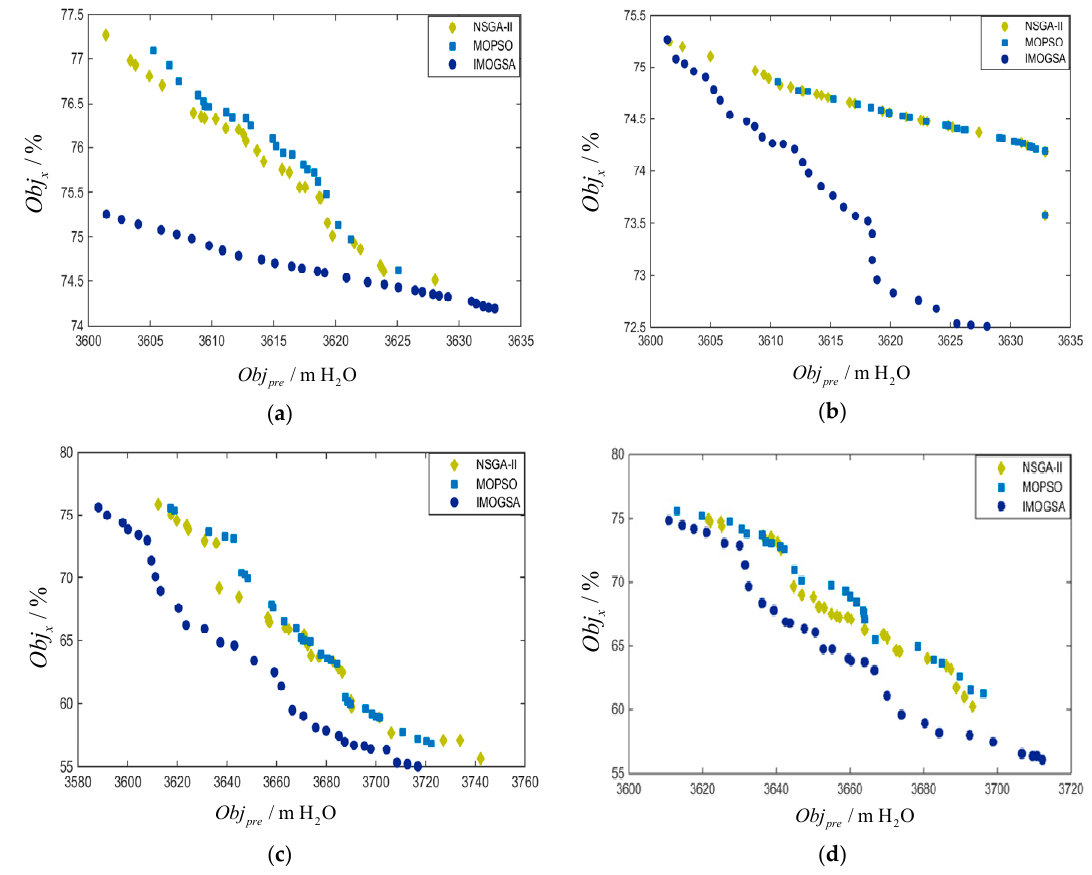
Figure 8. The Pareto front obtained by different algorithms: ( a ) scenario 1; ( b ) scenario 2; ( c ) scenario 3; and ( d ) scenario 4.